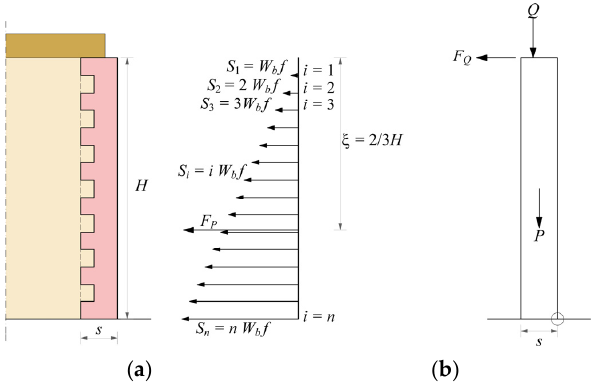
Figure 4. Frictional resistances transmitted to the façade wall by the shear walls ( a ) and the simply ‐ supported horizontal diaphragm ( b ).